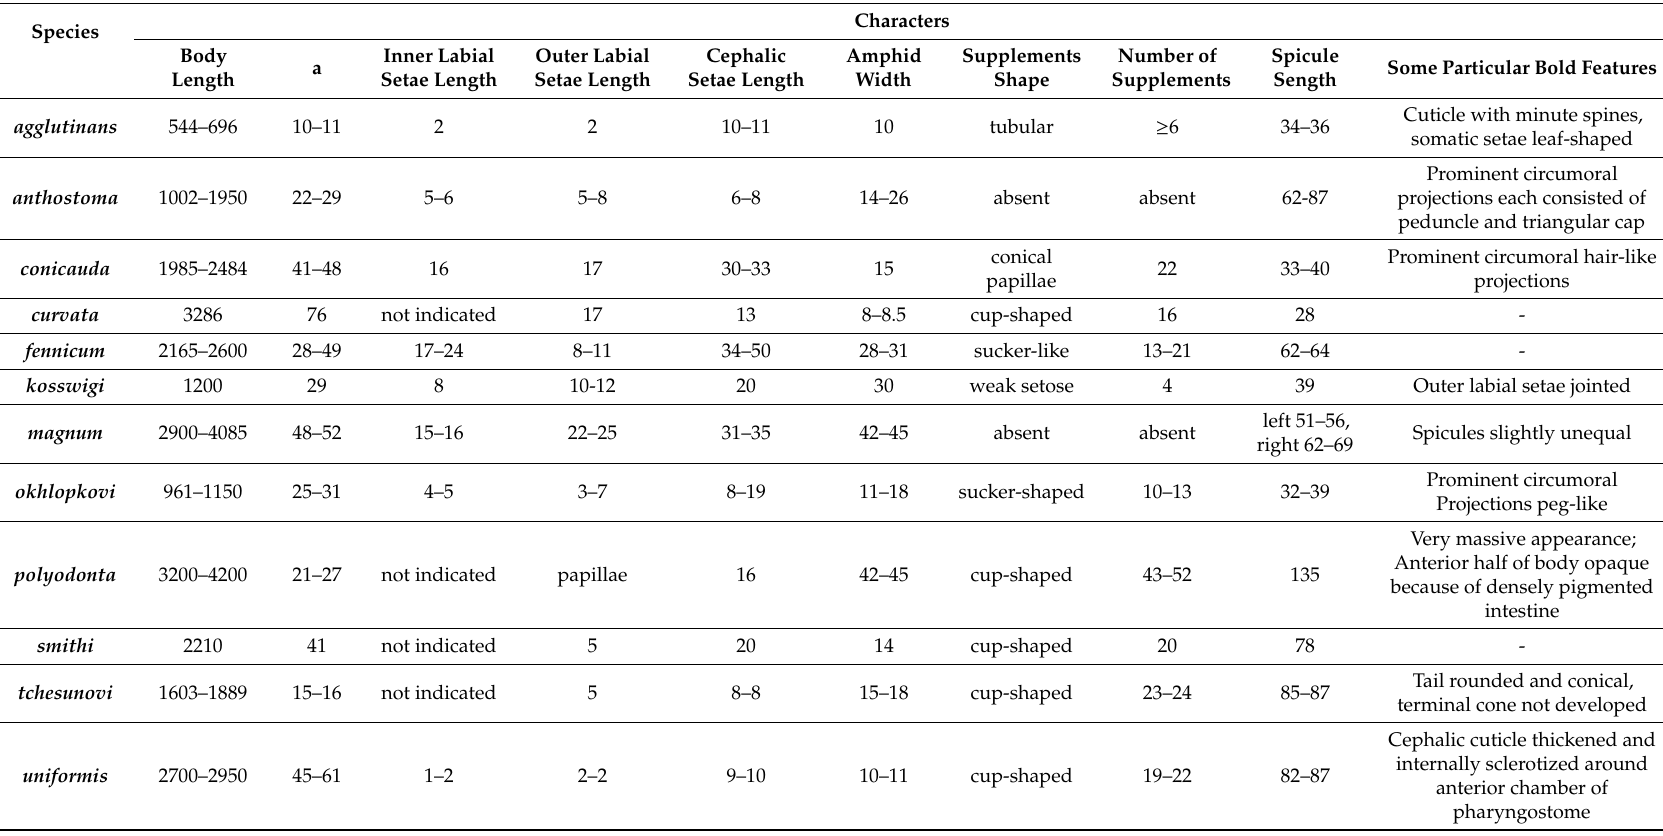
Table 1. Gammanema valid species, comparison of